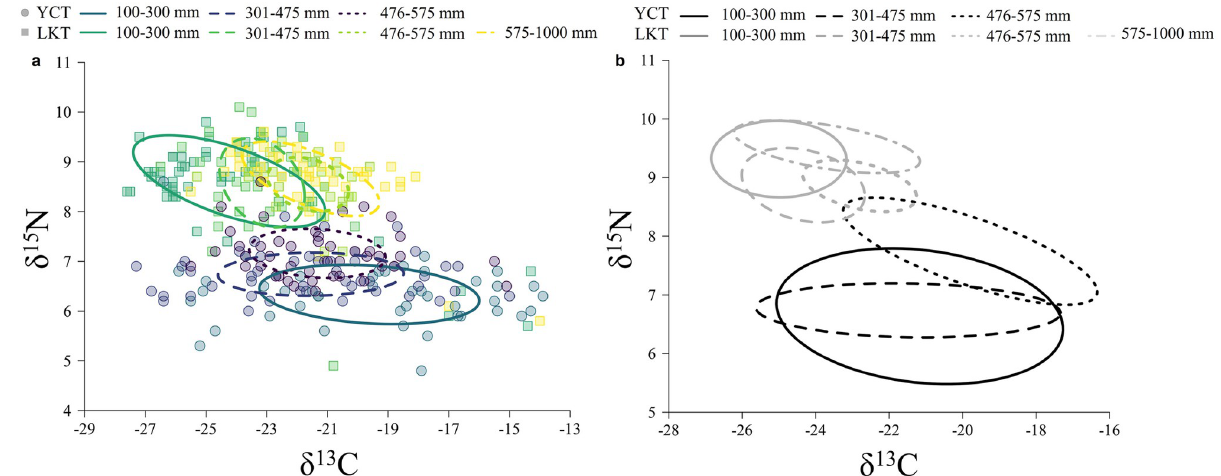
Fig 6. Comparison of stable isotope signatures and ellipse areas between native and invasive trout. Individual stable isotope values ( δ 15N, δ 13C) and standard Bayesian ellipse areas for Yellowstone cutthroat trout (YCT) length classes (circles; purple hues) and lake trout (LKT) length-classes (squares; green hues) sampled from Yellowstone Lake, 2018–2019, during moderate density state (a) and standard Bayesian ellipse areas for high- density state Yellowstone cutthroat trout (YCT) length classes (black) and lake trout (LKT) length-classes (grey) from Syslo et al. [53] (b). Note that the scales of x-axes on the panels are